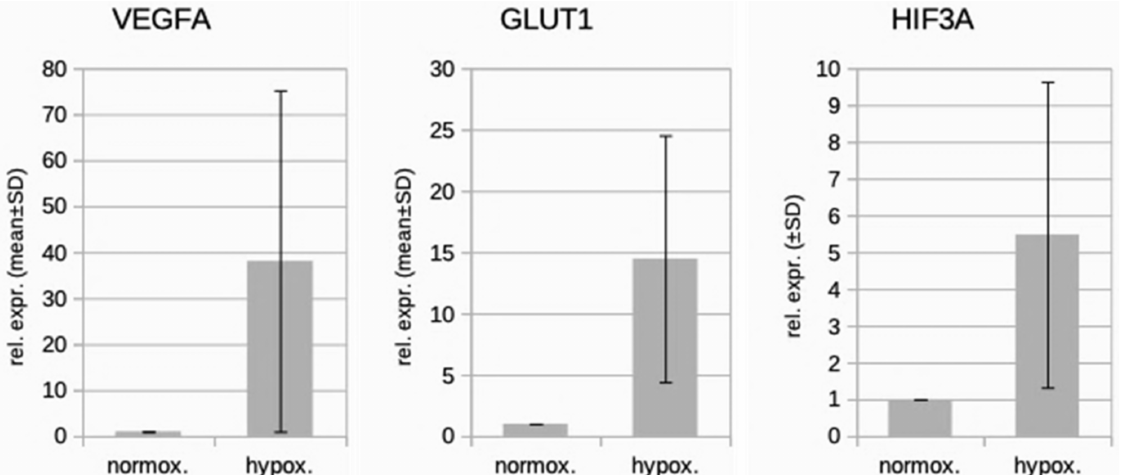
Figure 2. Real-time PCR analysis of HD-LECc5, HD-LECc6, and HD-LECc7 under normoxic (21% O 2 ) and hypoxic (1% O 2 ) conditions. Mean values from the three independent LEC donor samples are shown as bars; standard deviation as error bar. Mean values for normoxia were set to 1 to make samples comparable with the 2 − ∆∆ CT -method. Note the up-regulation of VEGF-A , GLUT1 , and HIF3A by hypoxia. Calculations and plot were performed using Microsoft Excel 16 (Microsoft, Redmond, WA,